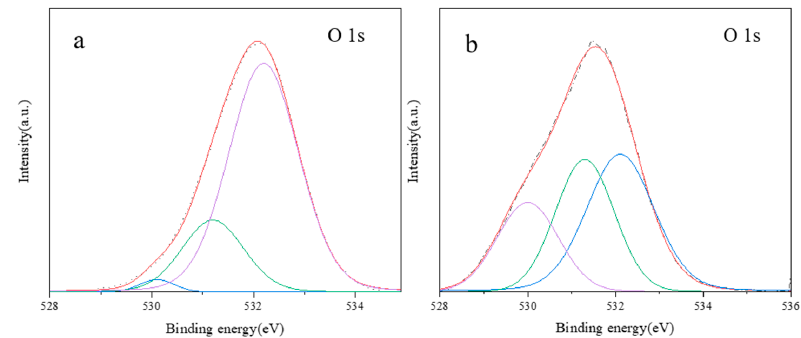
Figure 4. X-ray photoelectron spectroscopy (XPS) of sample ( a ) SiAl-1 and ( b ) SiAl-2. Table 1. O 1s content of different species in SiAl-1 and SiAl-2 from XPS. Sample